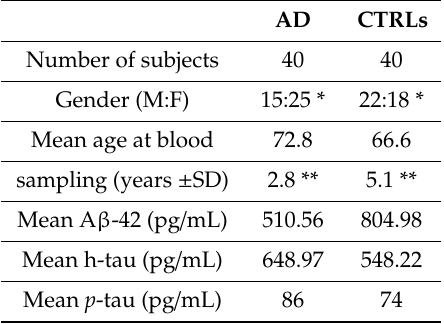
Table 1. Characteristics of patients and